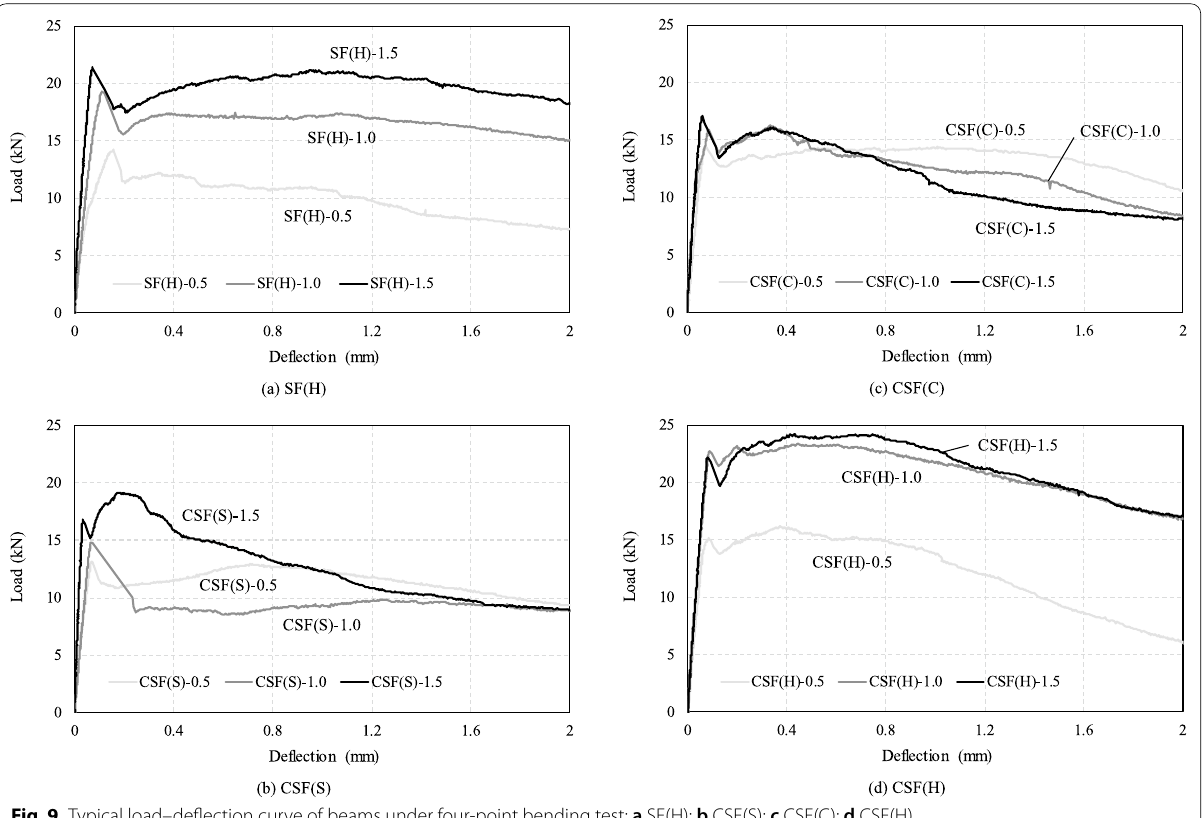
Fig. 9 Typical load–deflection curve of beams under four‑point bending test: a SF(H); b CSF(S); c CSF(C); d